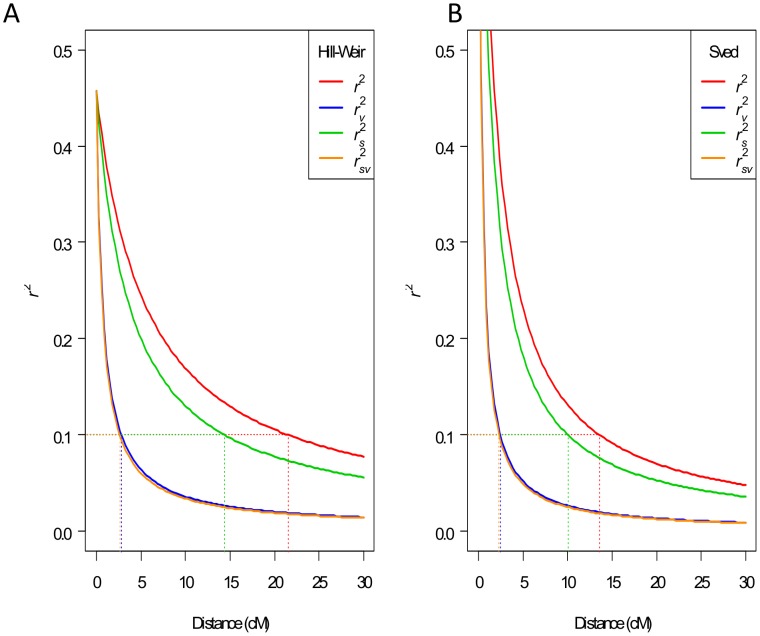
LD decay plot.
r2 estimates were plotted against the average map distance (recombination frequency expressed in cM): (A) relationship fit using the mutation model (Hill-Weir), (B) relationship fit using the recombination-drift model (Sved). Population structure was estimated using the k10 correction.